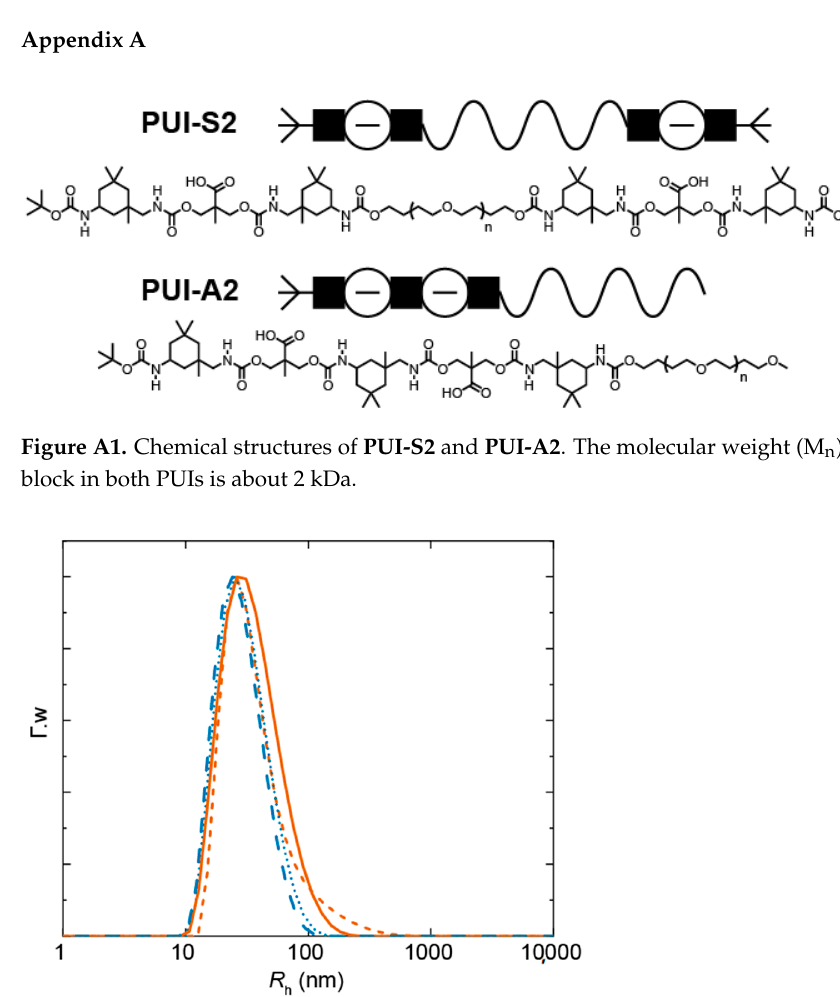
Figure A2. Size distributions from Contin analysis at 90° from DLS of PUI-S2 :PMVP 29 -PEO 204 (orange) and PUI-A2 :PMVP 29 -PEO 204 (blue) freshly prepared (dotted and dash) and after 7 days of storage (solid and long dash).